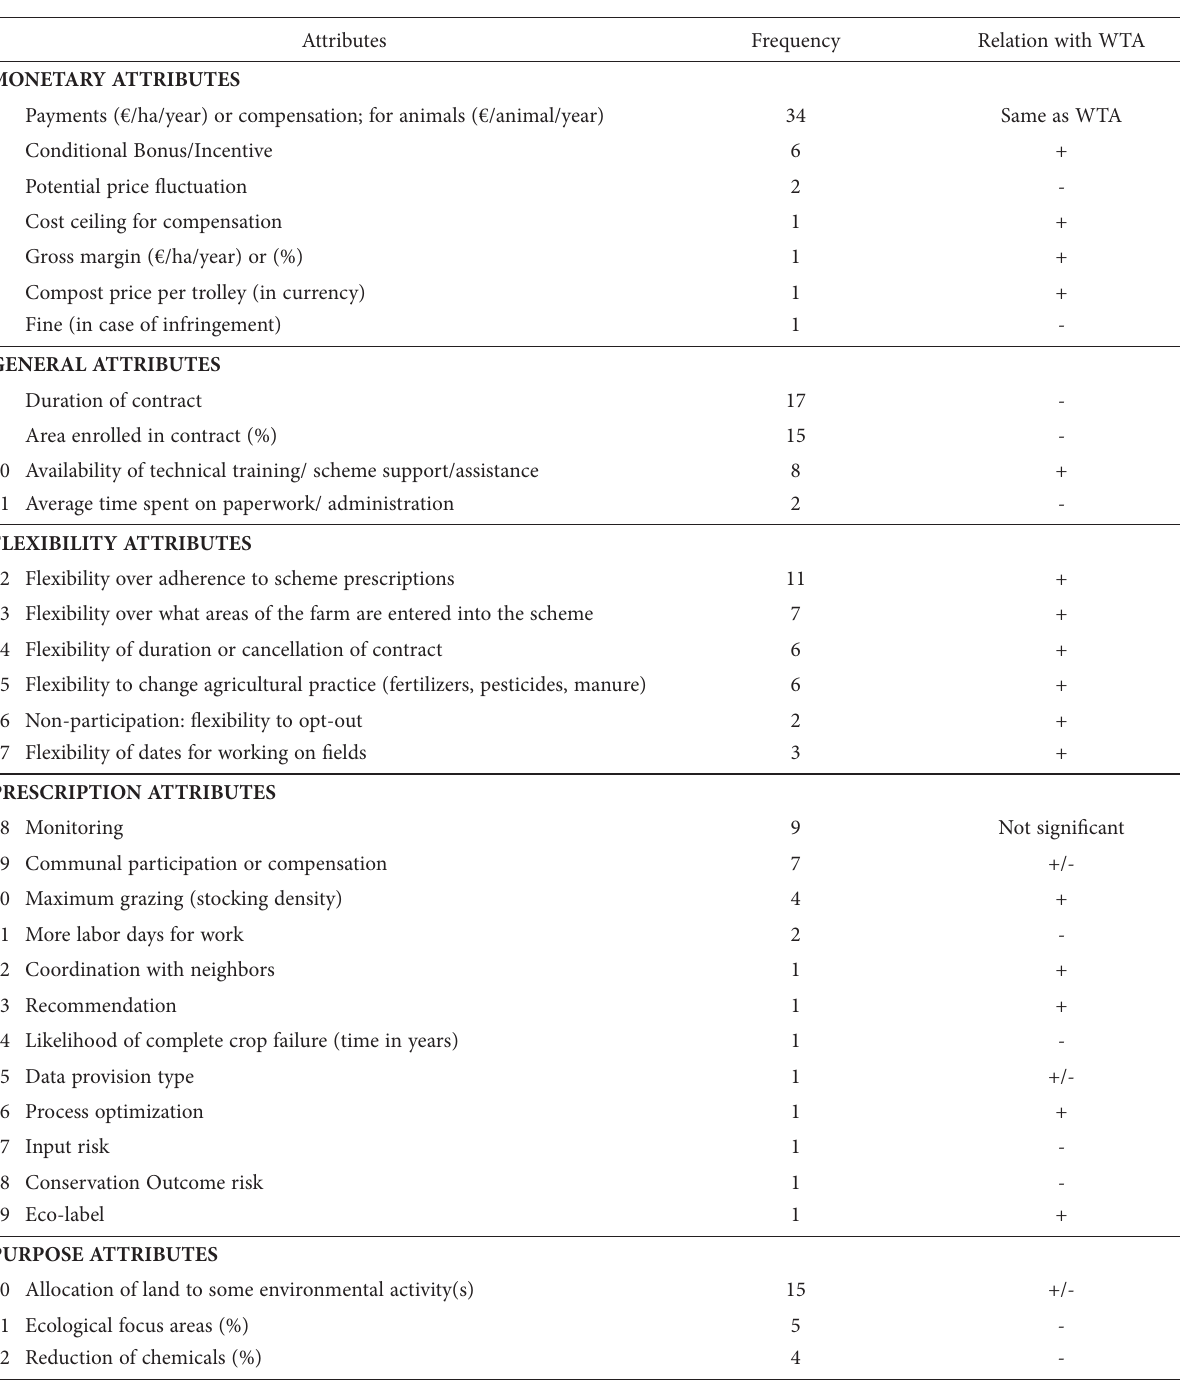
Table 1. Attributes found in the